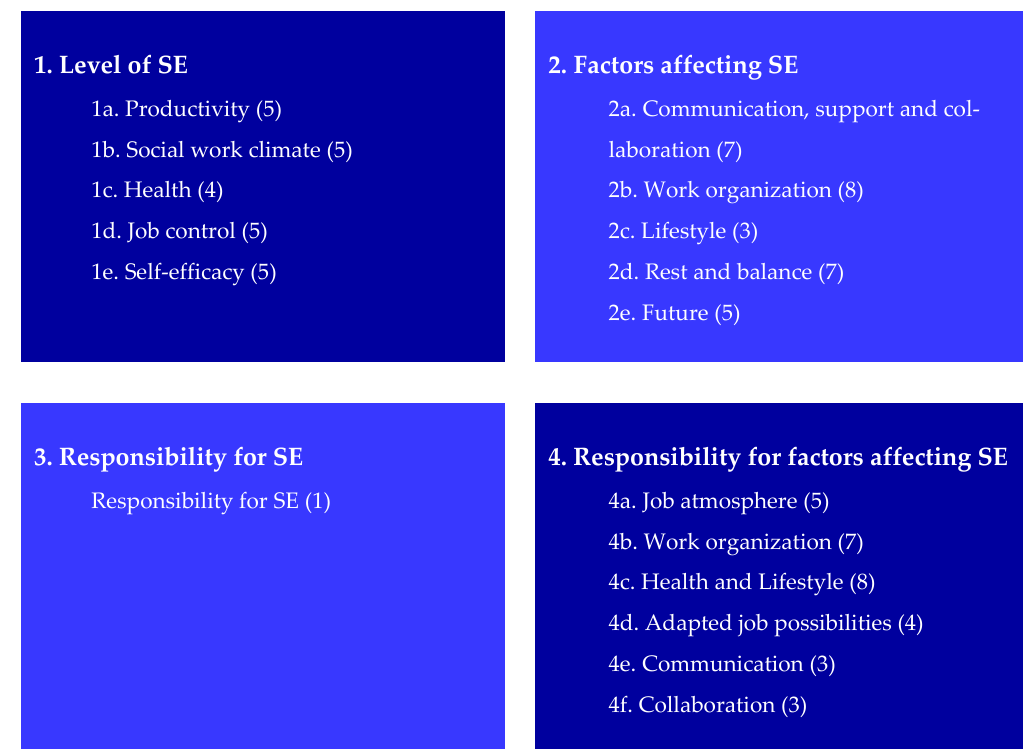
Figure 2 . Areas, scales and number of items per scale of the MAISE-Easy after adaptations based on PCA.